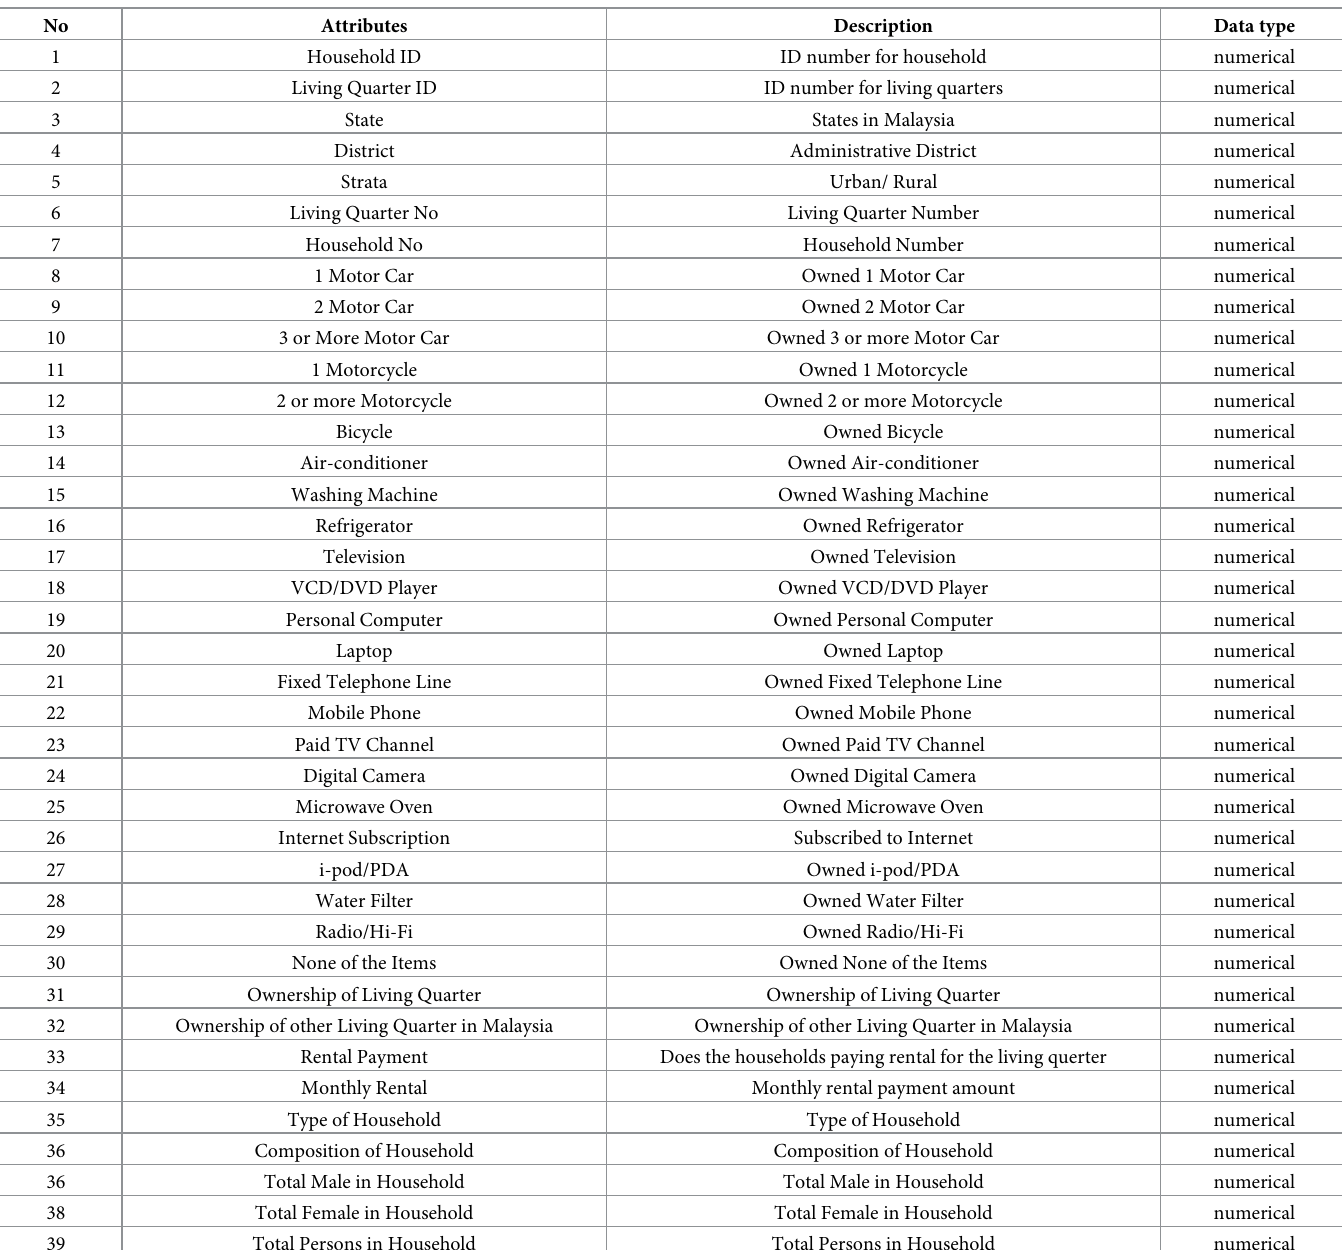
Table 3. A set of attributes from household source